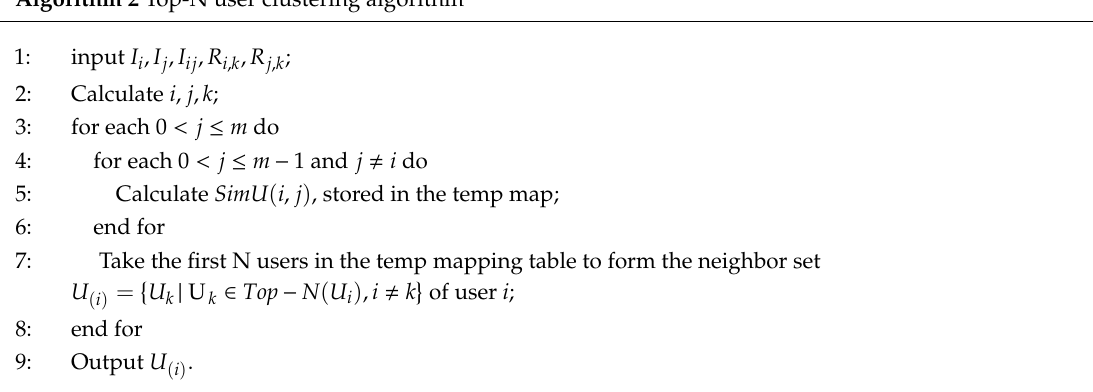
Algorithm 2 Top-N user clustering